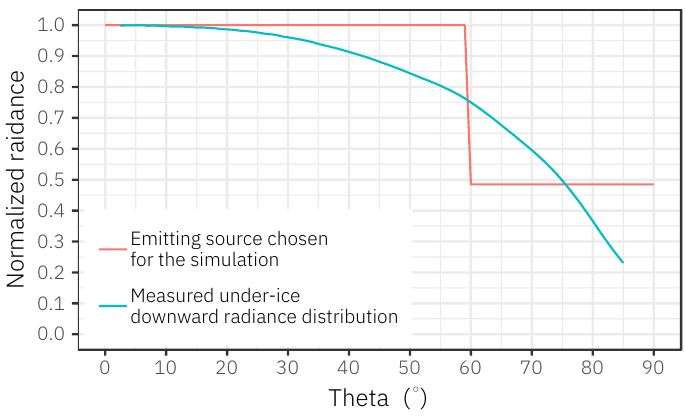
Figure 2. Comparison of the under-ice measured downward radiance distribution (the average cosine is 0.61, [18]) and the angular distribution of light-emitting source used in the ≈